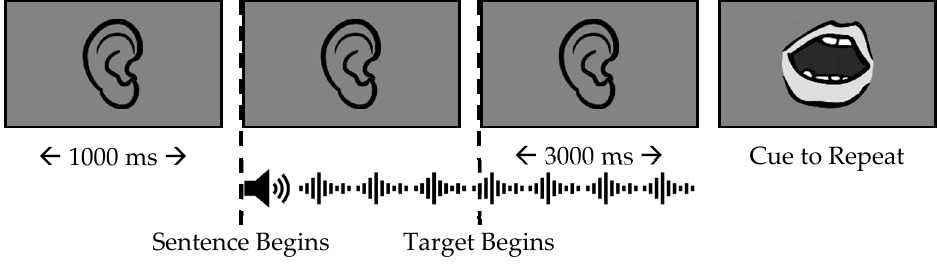
Figure 1. Trial Design.